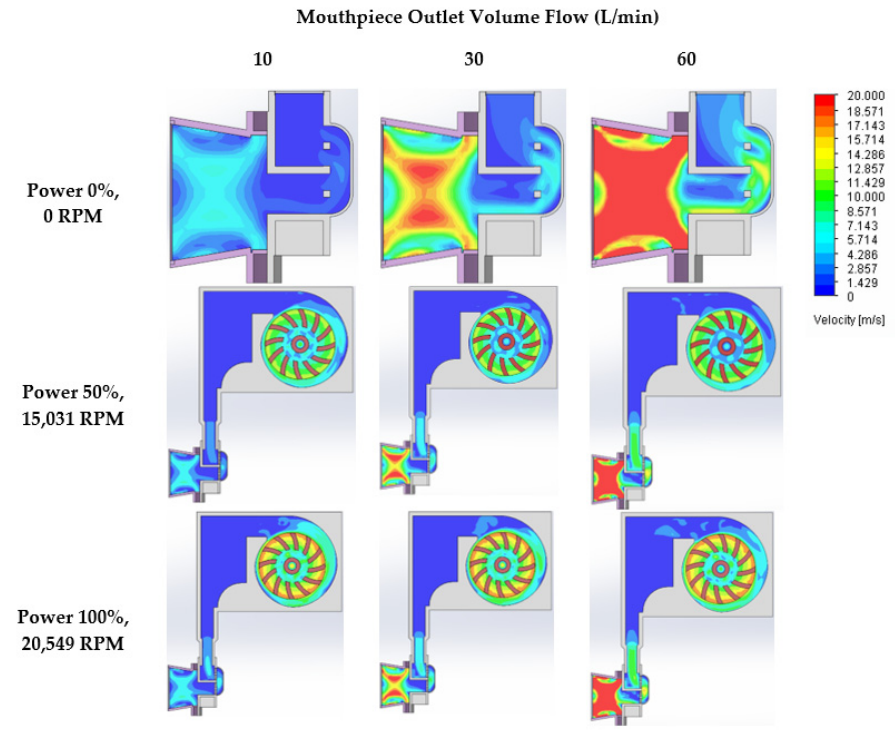
Figure 11. The contour plots of the air velocity with different mouthpiece outlet volume flow and fan rotating speed as determined through CFD simulation.